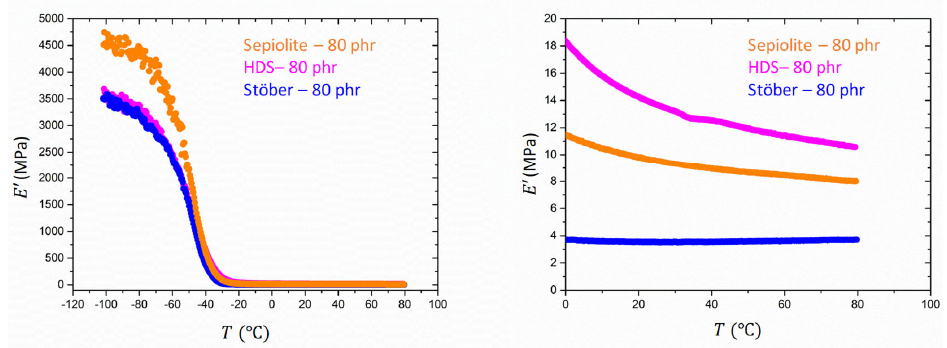
Figure 4. Evolution of 𝐸 (cid:4593) with temperature for the reference SBR samples, HDS ‐ 80 phr (magenta), Sepiolite ‐ 80 phr (or ‐ ange), and Stöber ‐ 80 phr (blue). Sepiolite-80 phr (orange), and Stöber-80 phr